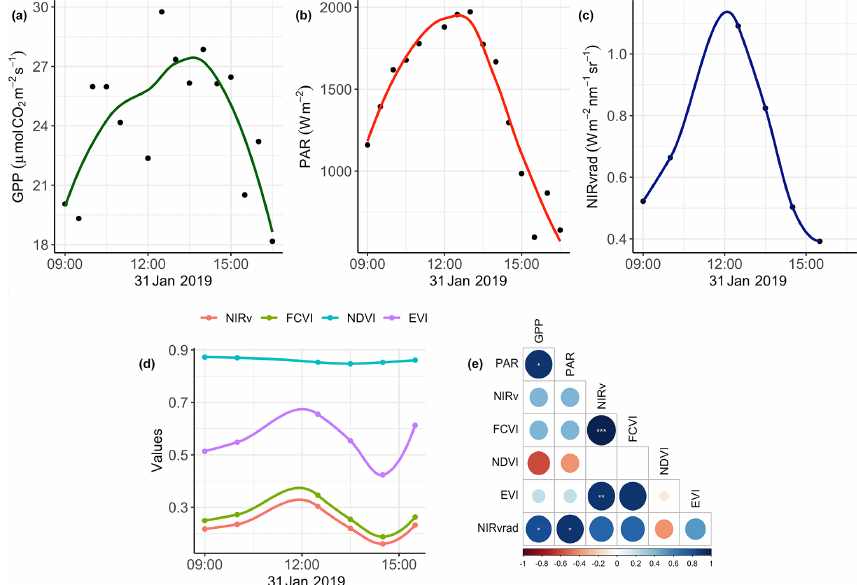
Figure 2. Diurnal time series smoothed with a LOESS filter of (a) GPP; (b) PAR; (c) NIRvrad; (d) NIRv, FCVI, NDVI, and EVI; and (e) comparisons of quantities using Pearson correlations color indicates strength of relationship: ∗ : p value < 0 . 05, ∗∗ : p value < 0 . 01, and ∗∗∗ : p value < 0 .